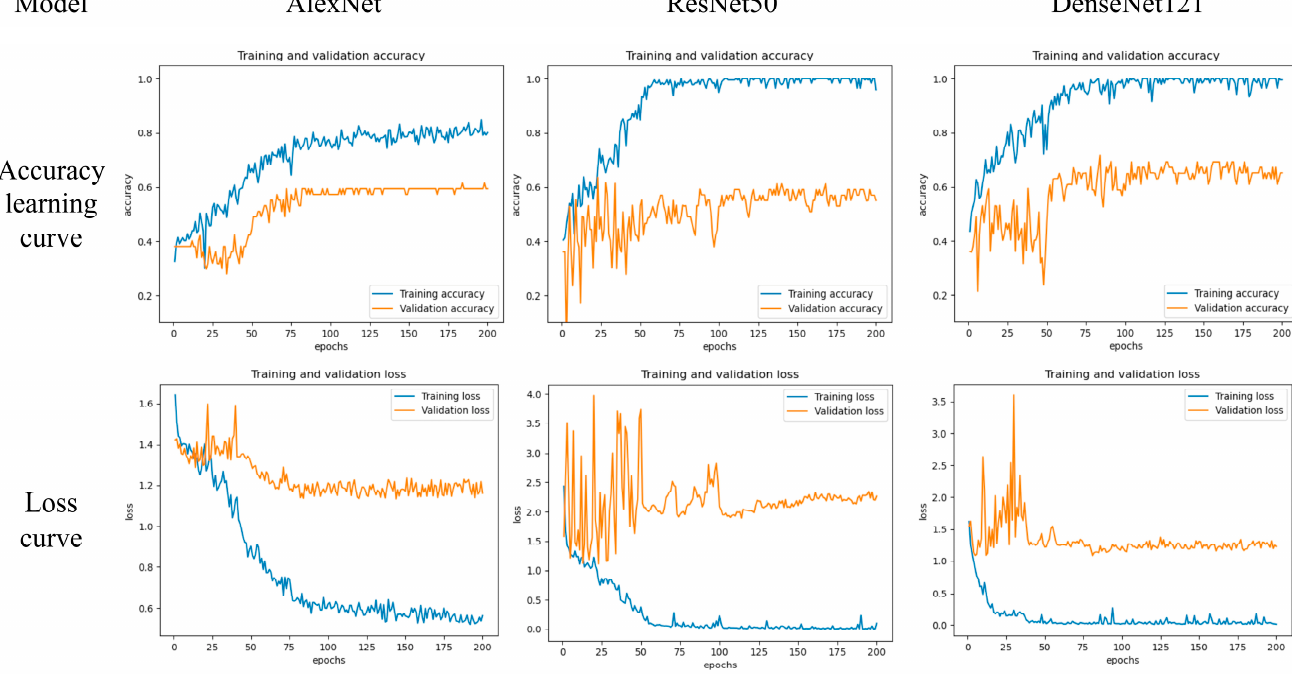
Table 5. Performance of three CNNs with settlement environment maps on the test set. The best metrics are highlighted in bold